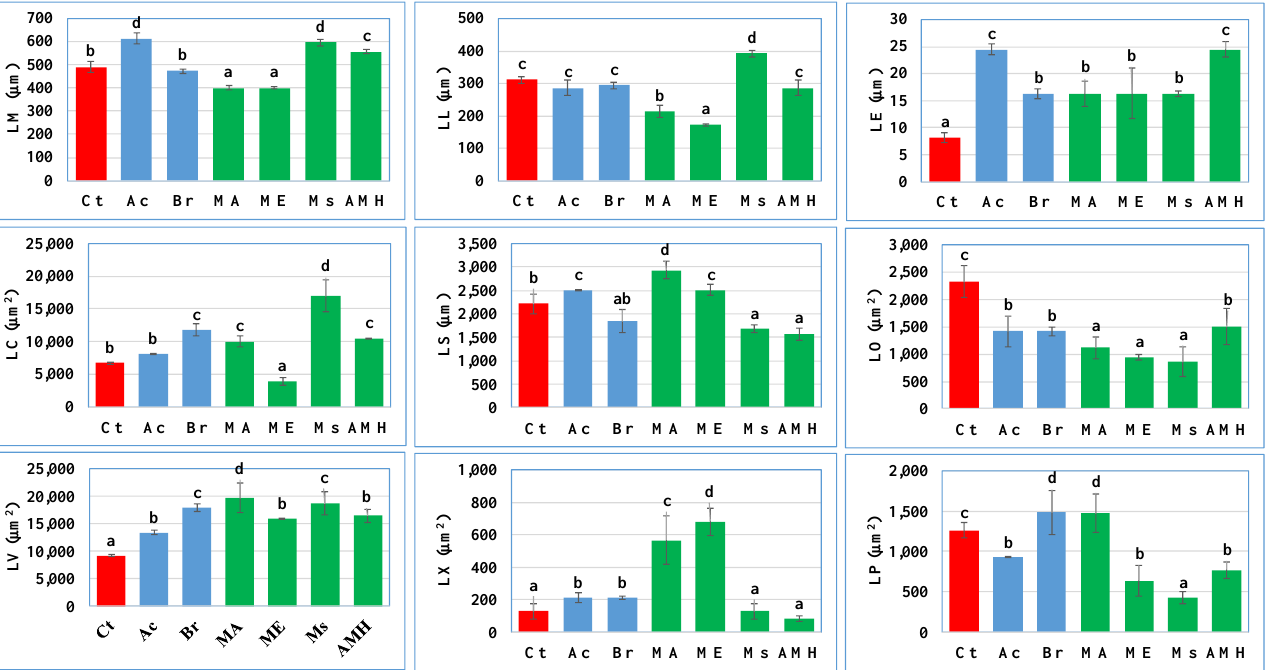
Figure 4. Leaf blade anatomical characteristics of Dactyloctenium aegyptium treated with pre- and post-emergence herbicides. Means sharing same lowercase letters on bars are statistically non−significant at p ≤ 0.05%) . Red bar indicates control group, blue bars show pre-emergence and green bars are used for post-emergence herbicides. For abbreviations please see list at the end of manuscript.